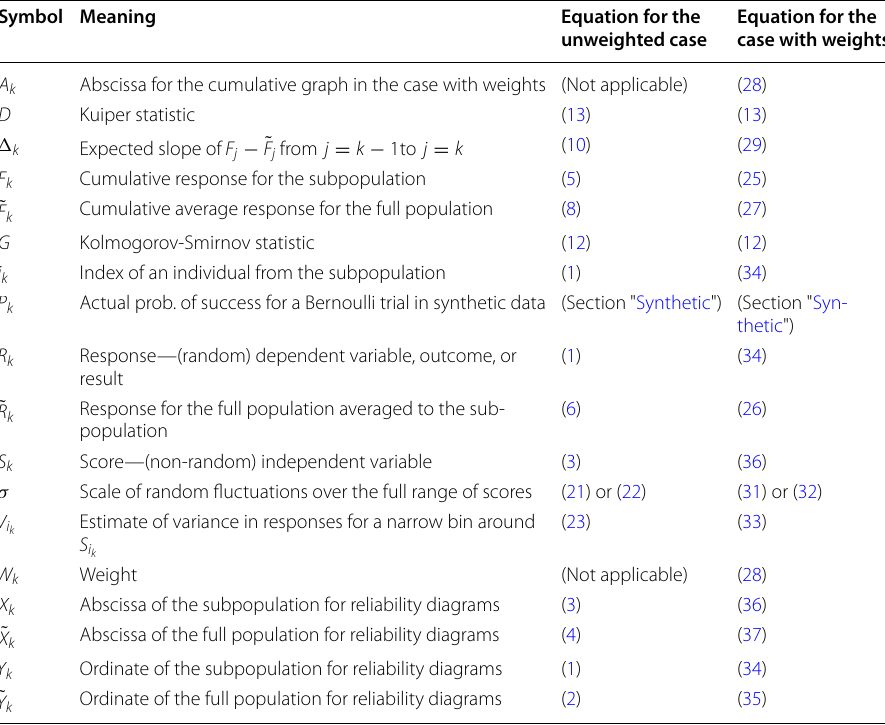
Table 2 summarizes the notation used in the appendices. The symbols in the tables are in alphabetical order